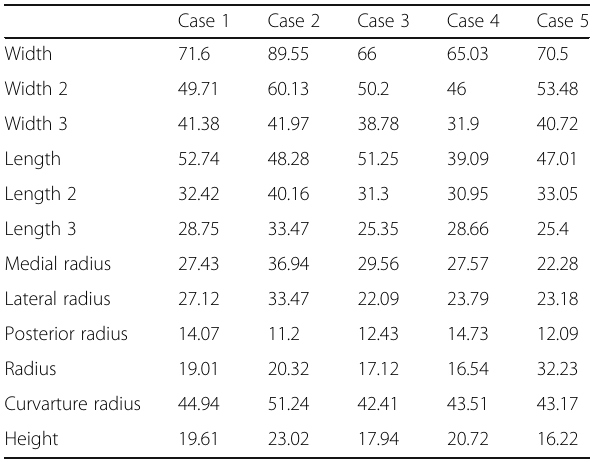
Table 4 Patient-specific geometrical data (Fig. 1).